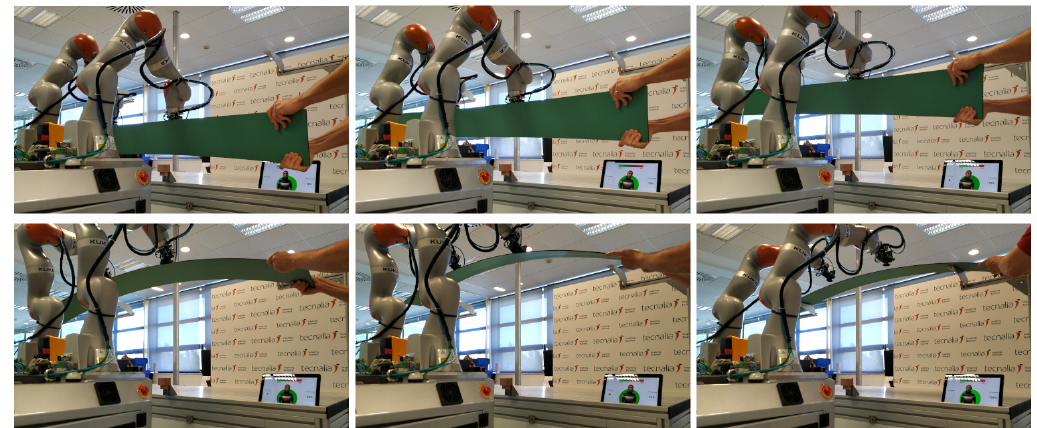
Figure 4. Transporting a carbon fiber part from fixtures to shelf during User Study 2